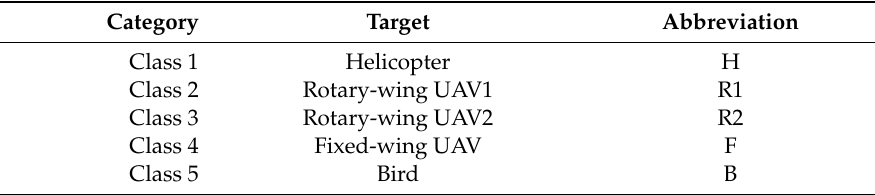
Table 4. The category of five LSS targets.